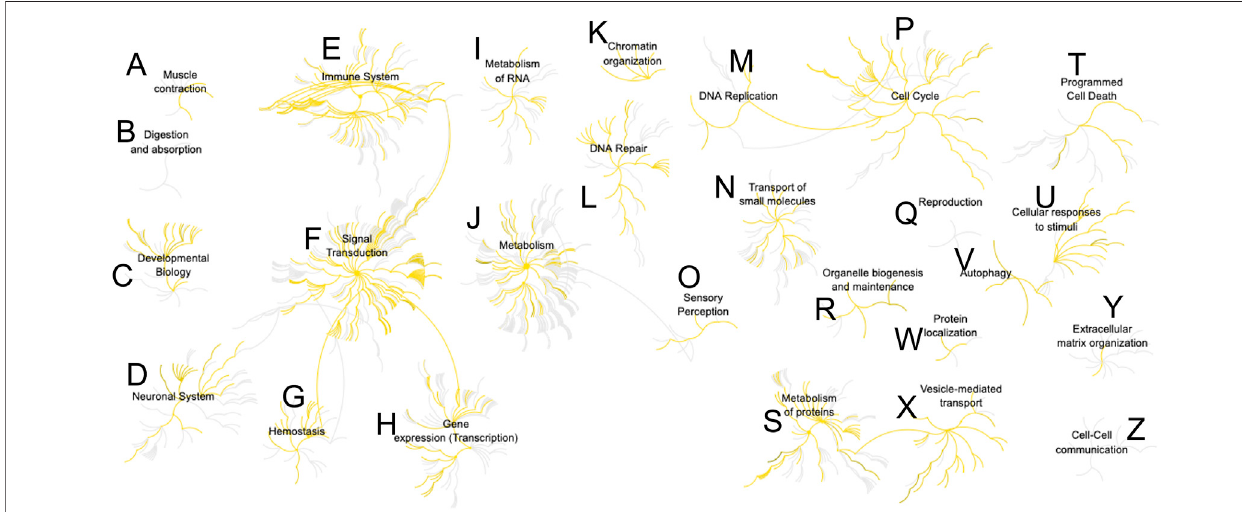
FIGURE 5 | Reactome analysis of protein-protein interactions from a single-neuron equivalent protein digest (500 pg proteome). More than 700 pathways were represented ( Supplementary Table S7 ). Detected nodes are highlighted in yellow. Pathway key: (A) , muscle contraction; (B) , digestion and absorption; (C) , developmental biology; (D) , neuronal system; (E) , immune system; (F) , signal transduction; (G) , hemostasis; (H) , gene expression; (I) , metabolism of RNA; (J) , metabolism; (K) , chromatin organization; (L) , DNA repair; (M) , DNA replication; (N) , transport of small molecules; (O) , sensory perception; (P) , cell cycle; (Q) , reproduction; (R) ,organellebiogenesisandmaintenance; (S) ,metabolismofproteins; (T) ,programmedcelldeath; (U) ,cellularresponsestostimuli; (V) ,autophagy; (W) , protein localization; (X) , vesicle-mediated transport; (Y) , extracellular matrix organization; (Z) , cell-cell